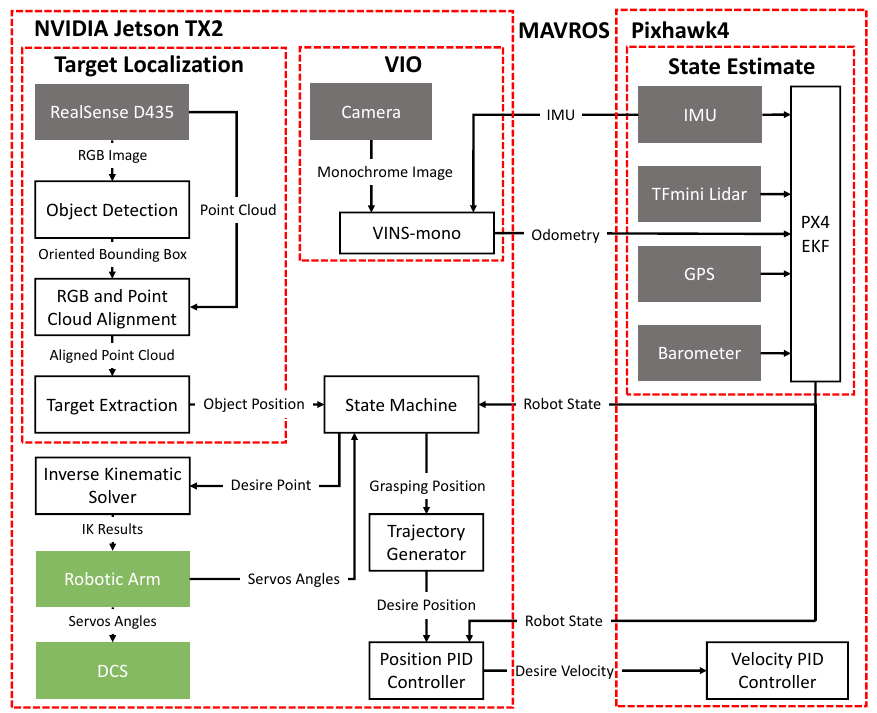
Figure 4. An overview of the software architecture. PID = Proportional Integral Derivative; IMU = Inertial Measurement